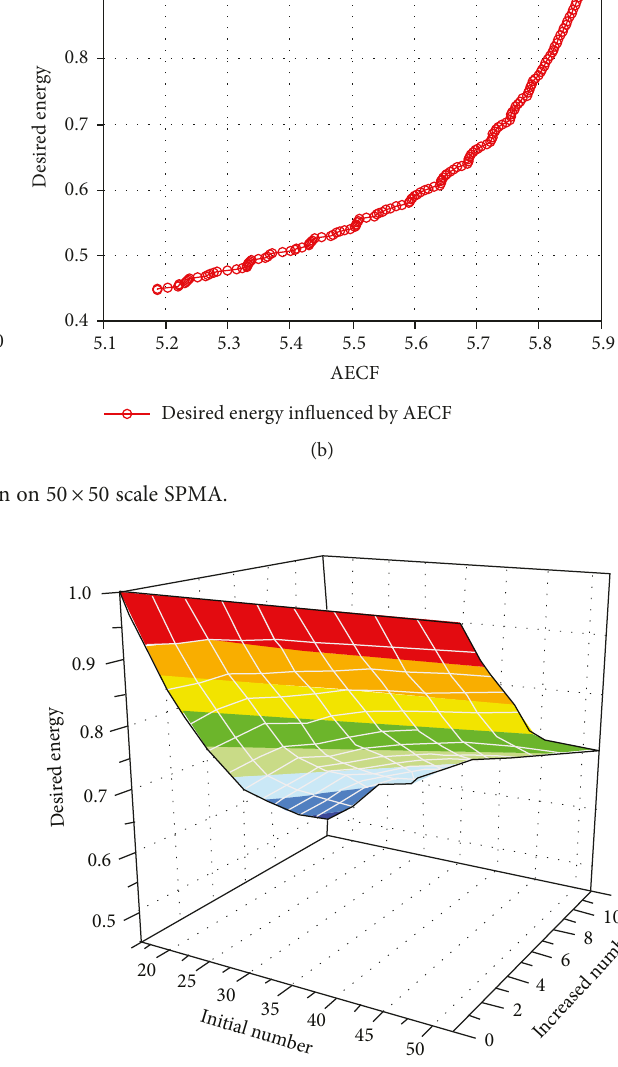
Figure 9: Changes in energy